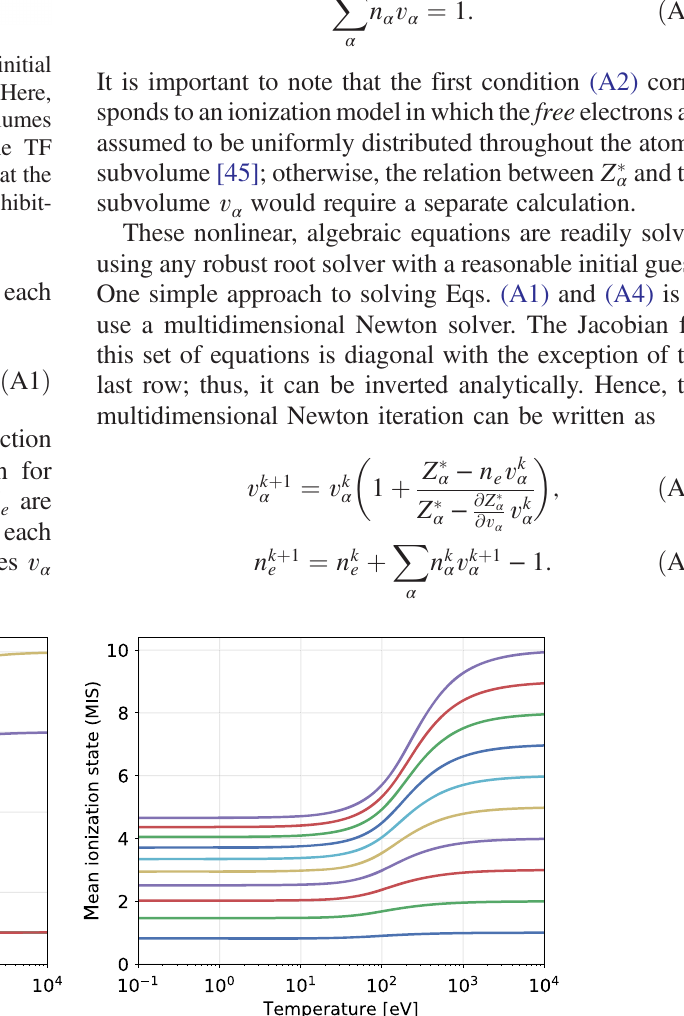
FIG. 14. Mixture mean ionization states. The MIS algorithm is illustrated for two cases. In the left panel, HDTCO mixtures with densities ð 1 ; 1 ; 1 ; 5 ; 0 . 5 Þ × 10 22 = cm 3 are shown. Because the hydrogen isotopes are electronically equivalent, their MISs are identical (overlapping lower curves). In the right panel, the MISs for a mixture of elements from Z ¼ 1 to Z ¼ 10 , each with the number density 10 23 = cc, are